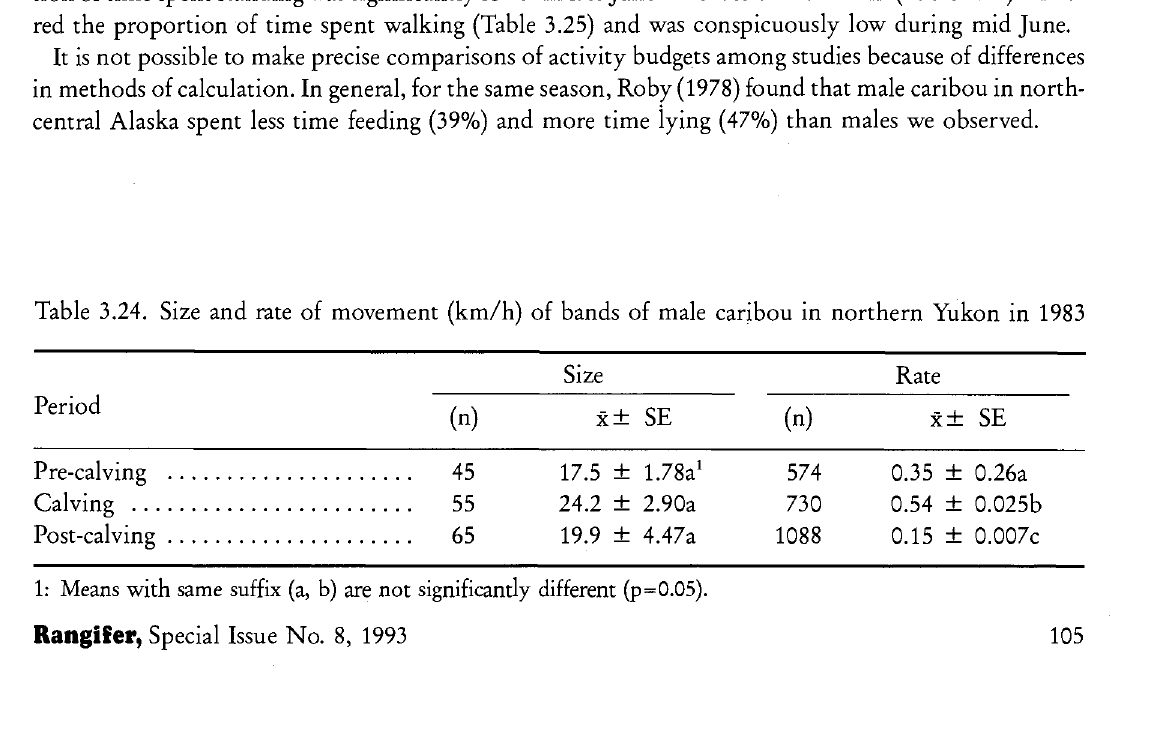
Table 3.24. Size and rate of movement (km/h) of bands of male caribou in northern Yukon in